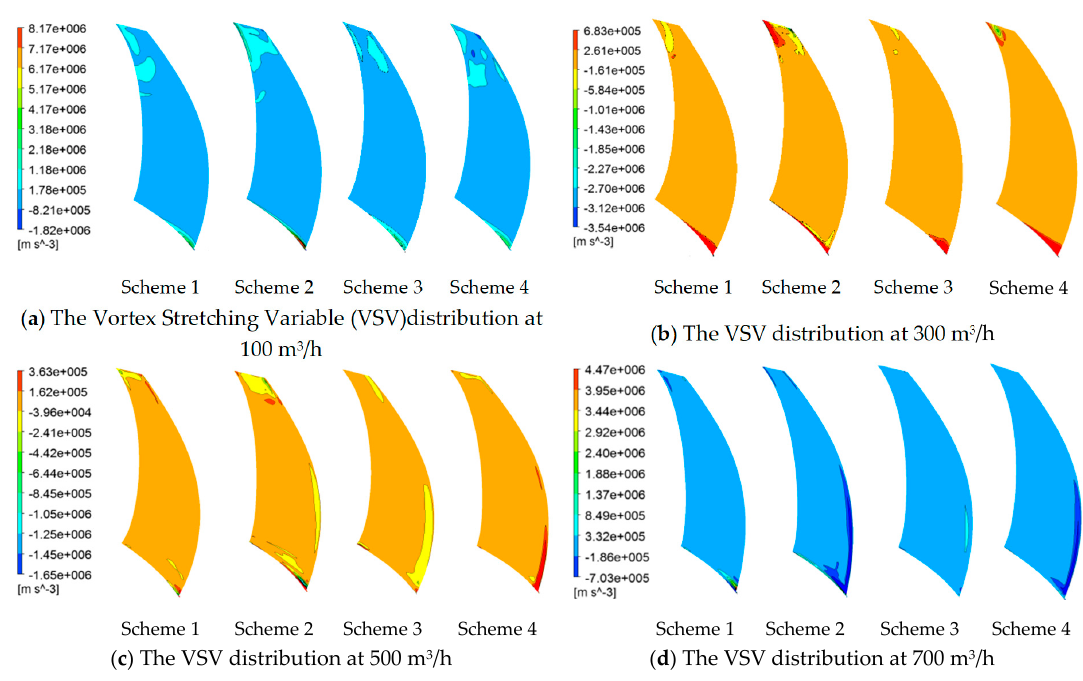
Figure 12. The VSV distribution at various flow conditions.